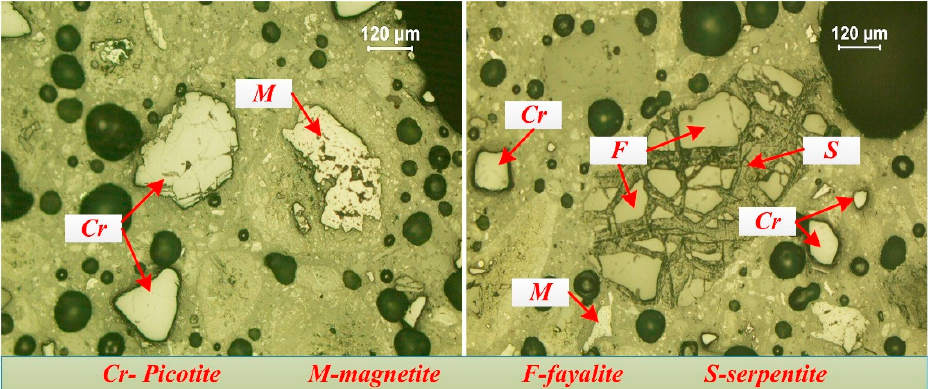
Figure 7. Micrographs of picotite in the nickel slag.